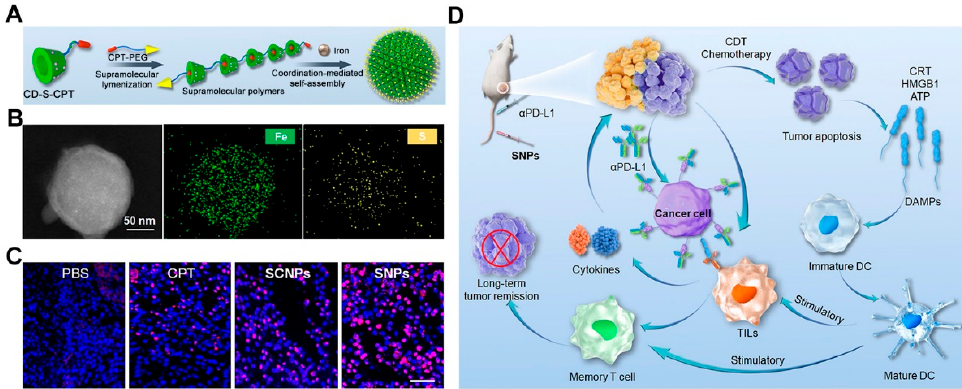
Figure 6. Schematic of SNPs for cancer immunotherapy. ( A ) Schematic of the assembly of the supramolecular monomer (CD-S-CPT) and construction of SNPs. ( B ) The elemental mapping of SNPs. ( C ) Representative images of TUNEL staining of the tumor tissues after treatment with different preparations. ( D ) Schematic of the mechanism of SNPs-based combination therapy with ICI to elicit anti-tumor immunity. Reprinted with permission from Ref. [146]. Copyright 2022, copyright Wiley- VCH.